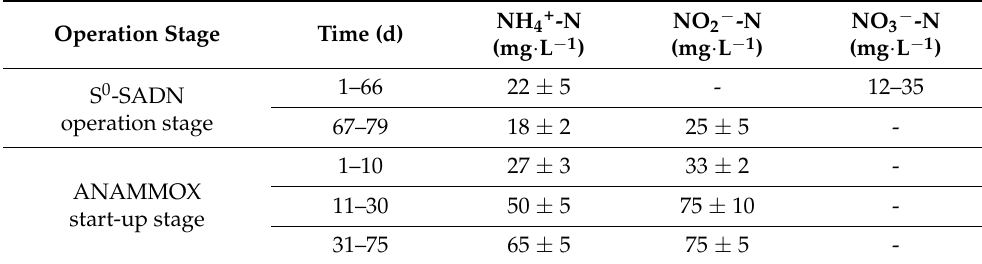
Table 1. Experimental operation